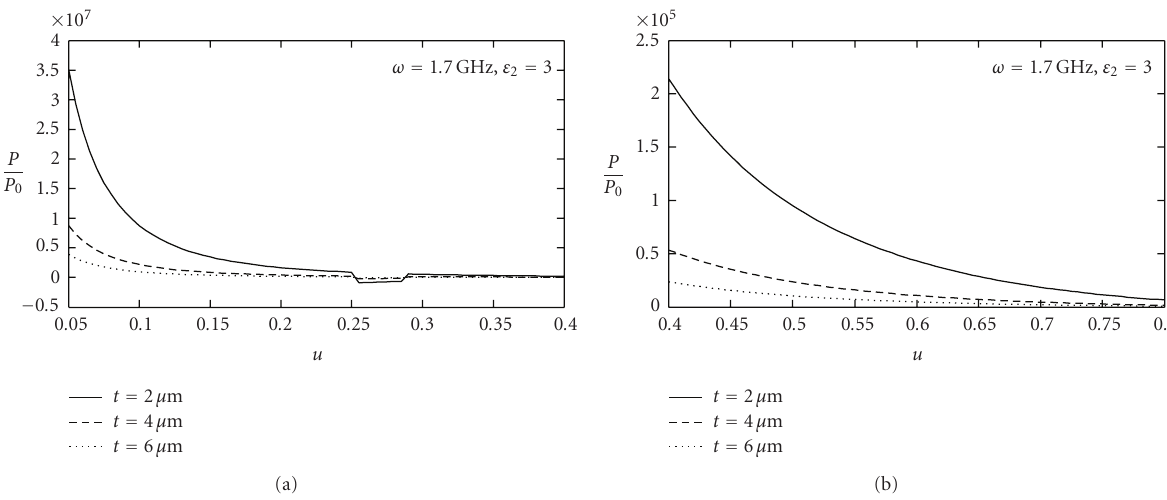
Figure 5: The normalized power flux versus optical nonlinearity at operating angular frequency and dielectric constant, ω = 1 . 7GHz, ε 2 = 3, for di ff erent dielectric film thicknesses.